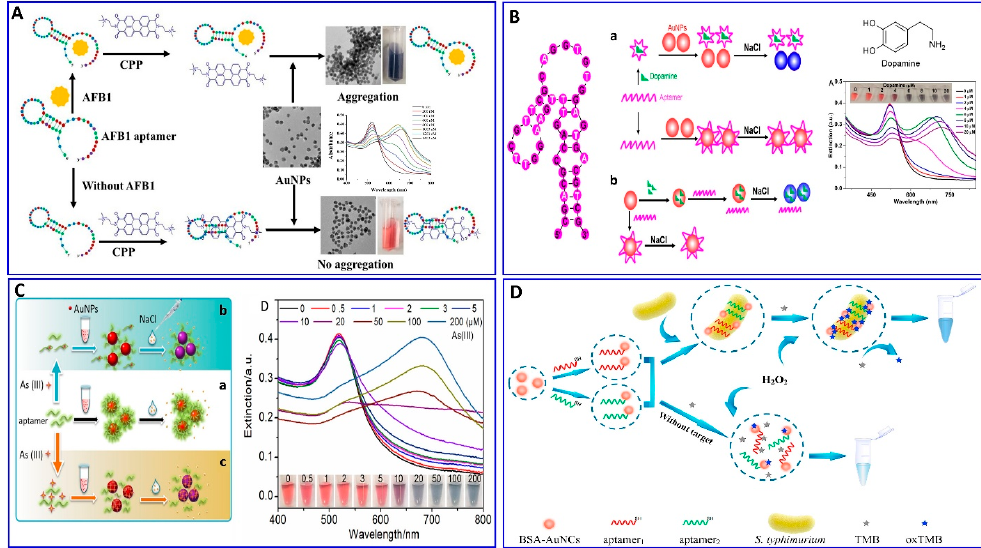
Figure 2. ( A ) Schematic illustration of AFB1 assay with the label-free colorimetric aptasensor using the competition between the specific aptamer, CPP, and AuNPs inducing AuNP aggregation, reproduced from [90]. ( B ) Schematic protocol of the dopamine assay via aptamer-assisted AuNP-induced NaCl salt aggregation with two possible mechanisms of sensing, reproduced from [91]. ( C ) Schemes of the As (III) assay based on the aptamer–As (III) competitive interaction inducing salt–AuNP aggregation, reproduced from [92]. ( D ) Schematic principle of S. typhimurium assay based on the peroxidase-mimicking activity of dual aptamers@BSA-AuNCs probes inducing a blue color for 3,3 ′ ,5,5 ′ -tetramethylbenzidine (TMB), reproduced from [97].